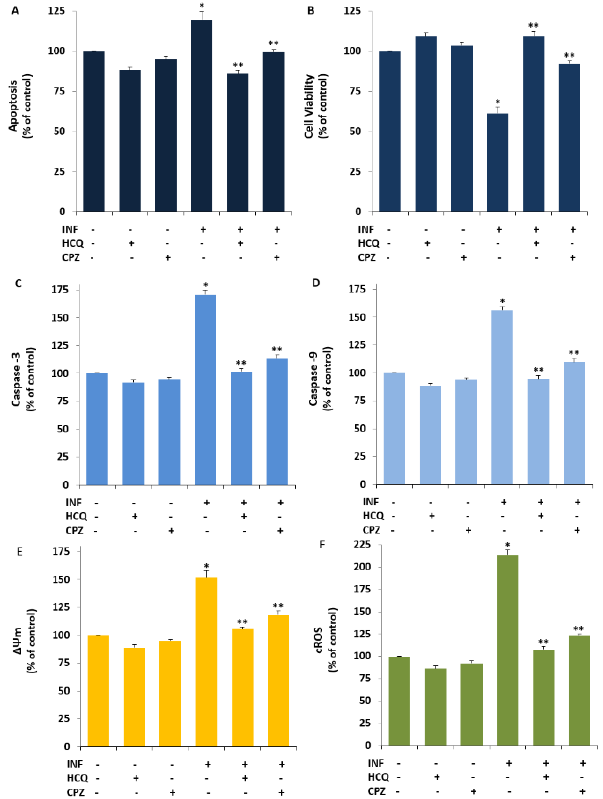
Figure 3. HCQ (60 µ M) and CPZ (0.1 mM) attenuated acute INF-induced the increase of apoptosis level, caspase activates via the increases of cell viability in the U937 cell (Mean ± SD and n = 6). The column bars of ( A – F ) are indicating the changes of apoptosis, cell viability, CAS3, CAS9, ∆Ψ m, and cROS in the six groups. For the apoptosis analyses, a commercial kit (Biocolor APOPercentage) was used, although cell viability level was analyzed by using MTT. The Ac-DEVD-AMC and Ac-LEHD- AF fluorogenic substrates were used for the analyses of cleavage CAS3 and CAS9, respectively. For the determination of ∆Ψ m, and cROS, the stains of JC1 and DCFH-DA were used (* p ≤ 0.05 vs. Cntr, HCQ, and CPZ. ** p ≤ 0.05 vs. INF). The significance of p -values was analyzed by using the test of